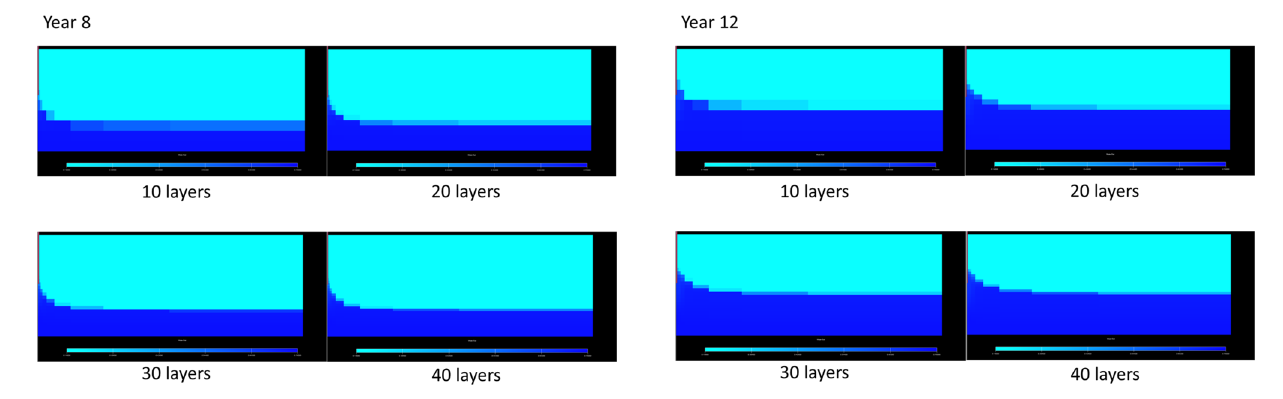
Fig. 13 Water saturation profile along a reservoir radius for 4 models with different layers after 8-year production